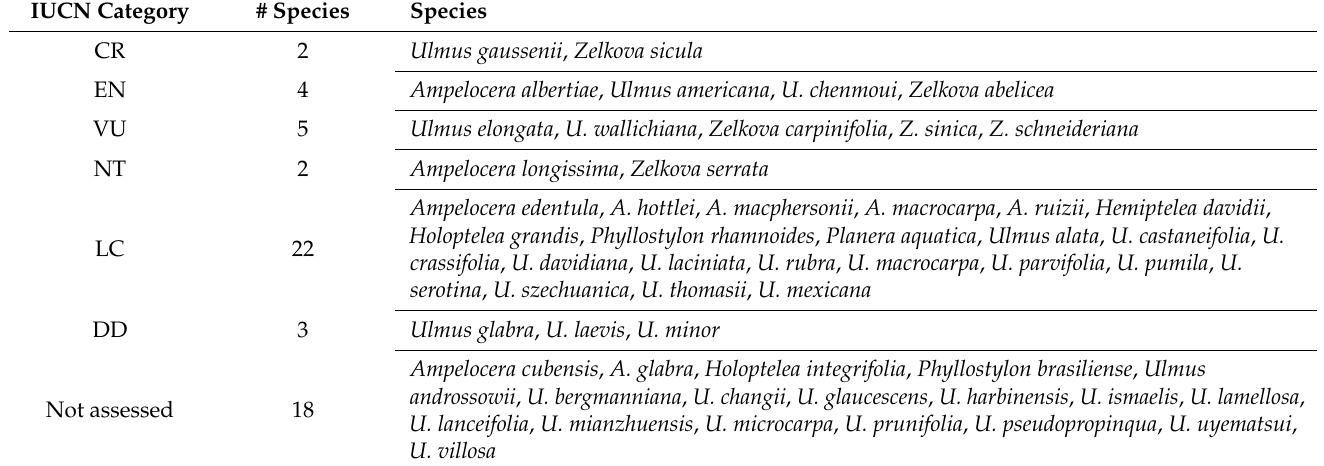
Table 3. Conservation status of the Ulmaceae species. IUCN categories: CR—critically endangered, EN—endangered, VU—vulnerable, NT—nearly threatened, LC—least concerned, DD—data deficiency (IUCN 2020). # Species: number of